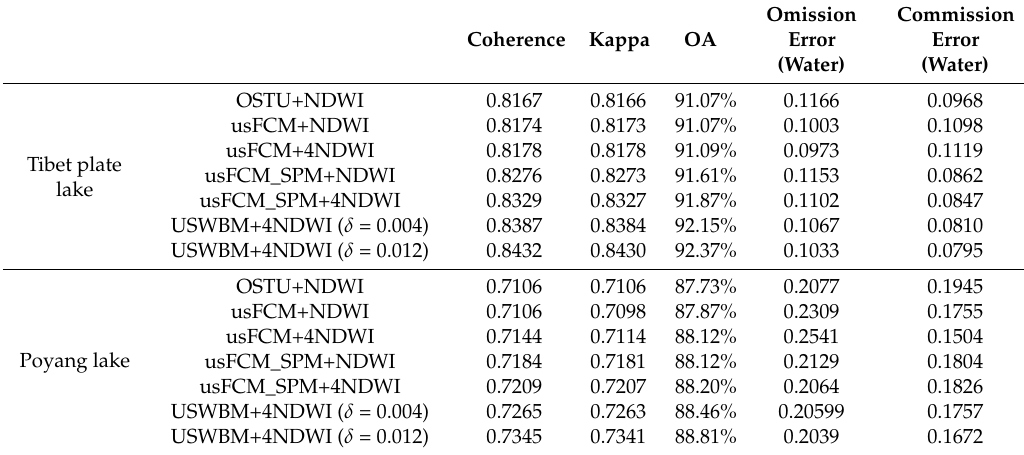
Table 3. Accuracy assessment of the water body maps produced by different algorithms for Tibet Plate lake and Poyang